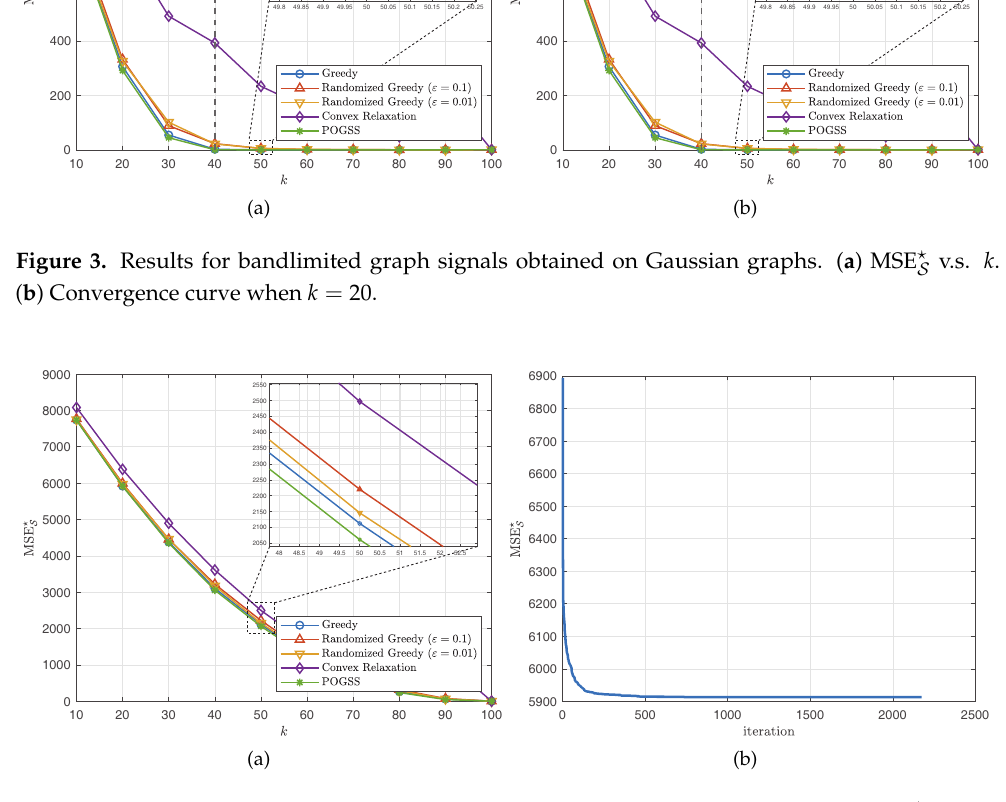
Figure 4. Results for non-bandlimited graph signals obtained on ER graphs. ( a ) MSE (cid:63) S v.s. k . ( b ) Convergence curve when k = 20.